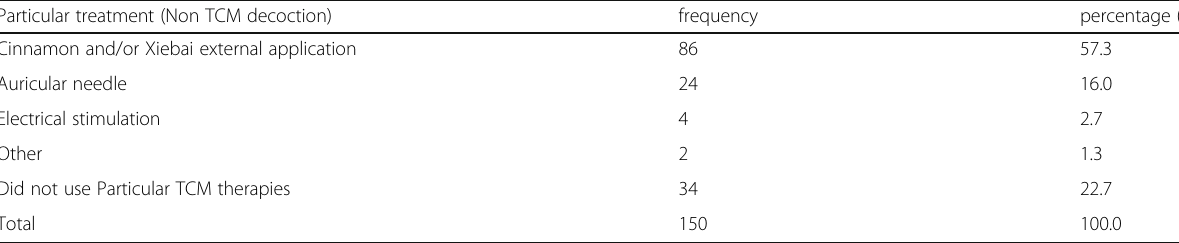
Table 10 TCM Particular treatment application of 150 cases Particular treatment (Non TCM